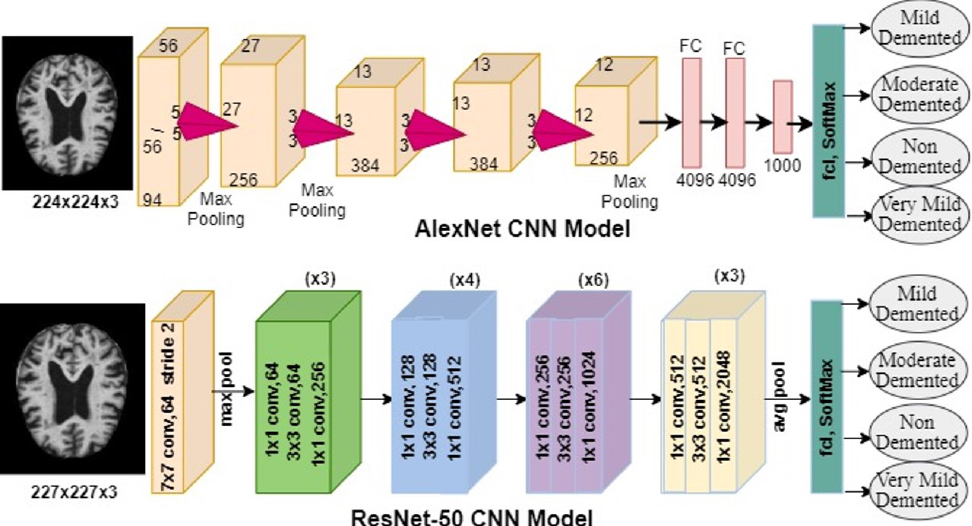
Figure 5. Architecture of the AlexNet and ResNet-50